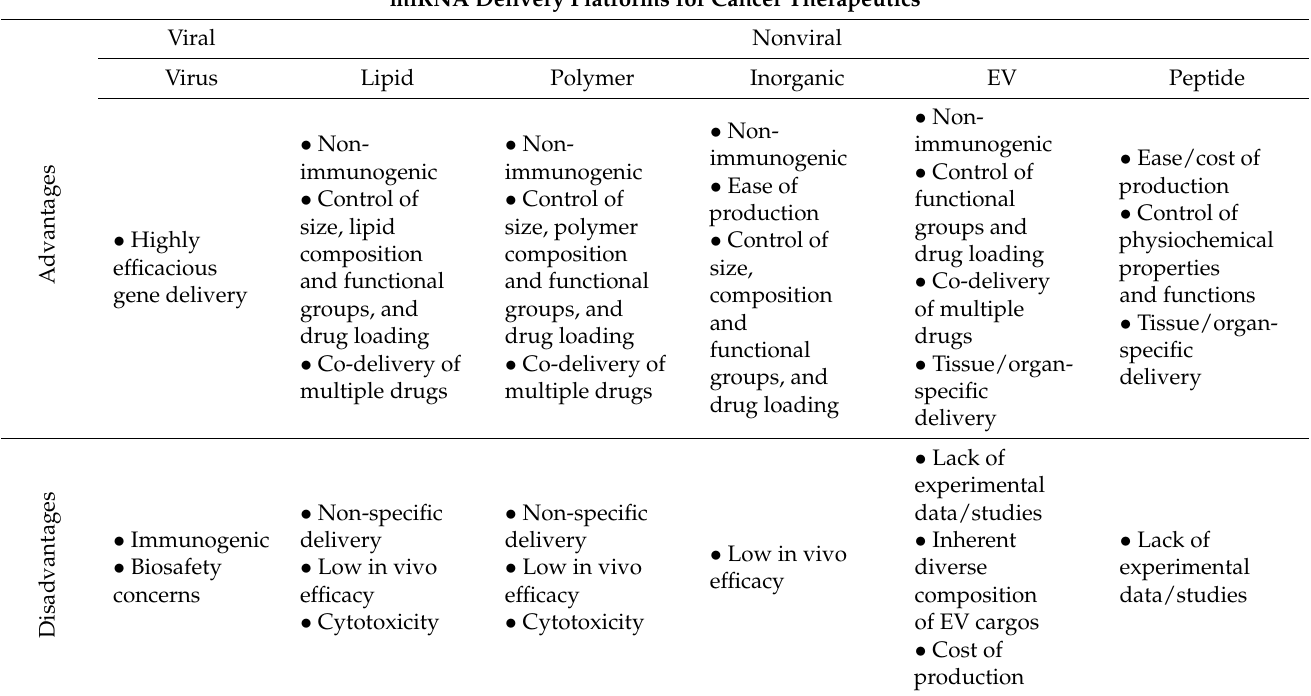
Table 2. The highlighted advantages and disadvantages of both viral and nonviral delivery systems in their transport of miRNA-based therapeutics for the treatment of